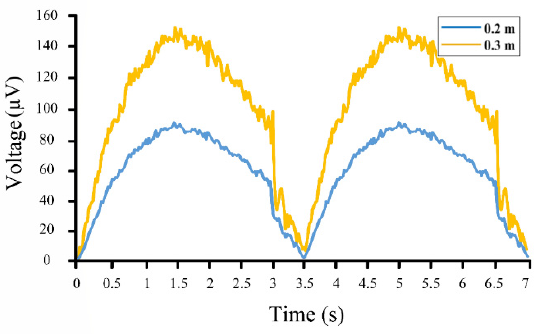
Figure 10. Results of the fabricated prototype for waves of 0.2 m (Blue line) and 0.3 m (Orange line) height with a 3.5 s period.